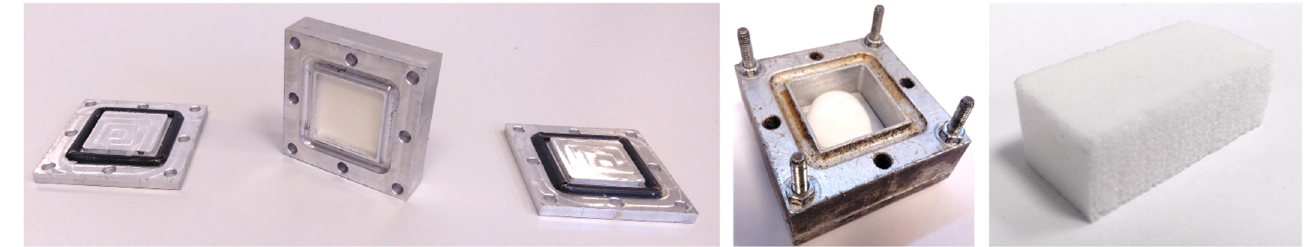
Figure 1. Left : small aluminum molds with a cavity of 30 × 30 × 10 mm 3 , Middle : mold filled with foam formulation, Right : halved foam specimen.